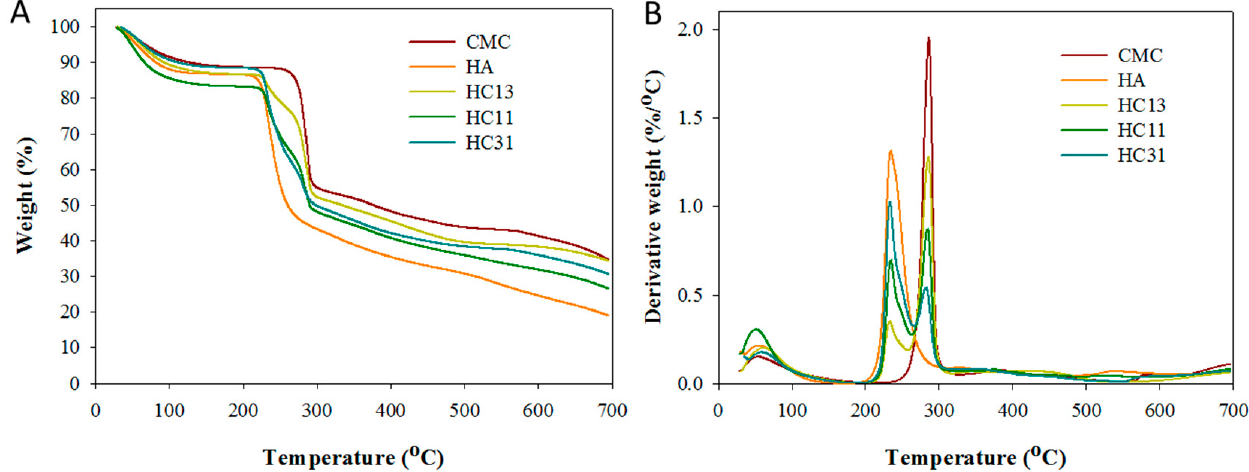
Figure 3. The thermogravimetric analysis (TGA) ( A ) and differential thermal gravimetric (DTG) analysis ( B ) of HA, CMC, and HA/CMC (HC) hydrogel prepared at 1/3 (HC13), 1/1 (HC11) and 3/1 (HC31) mass ratios of HAMA/CMCMA.